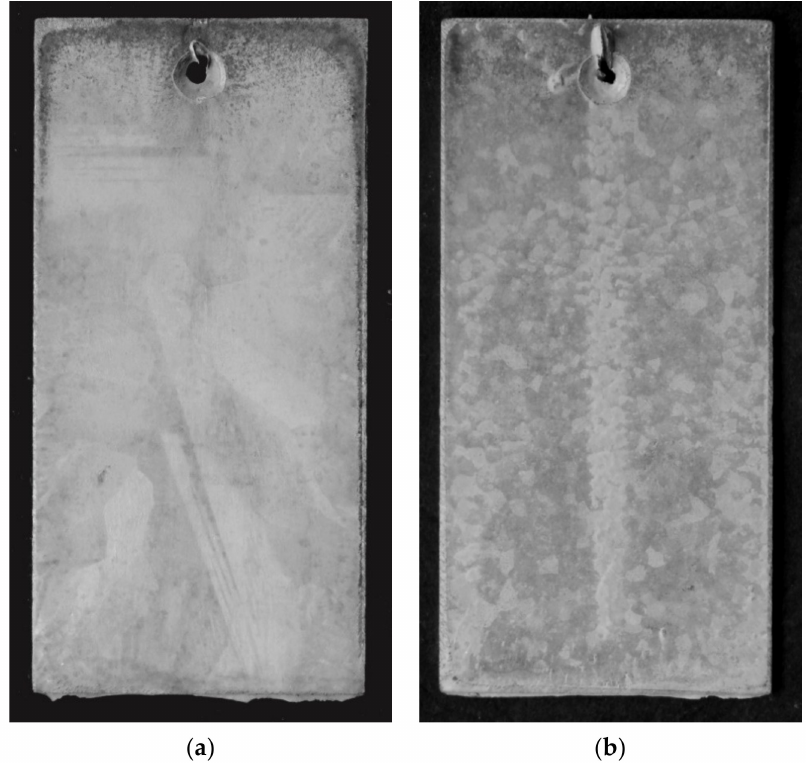
Figure 8. The outlook of the top surface of zinc coatings created in the: ( a ) Zn-AlNiBiSn, ( b ) Zn-AlNi baths after exposure in the Koesternich chamber.